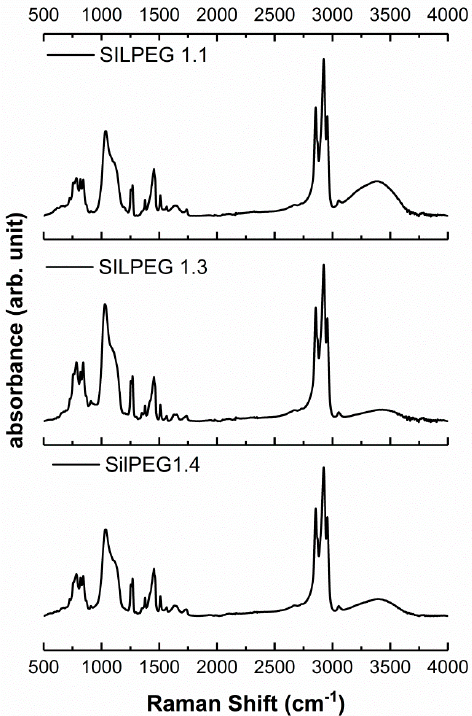
Figure A6. IR-ATR spectra of SilPEG1.1, SilPEG1.3, SilPEG1.4.